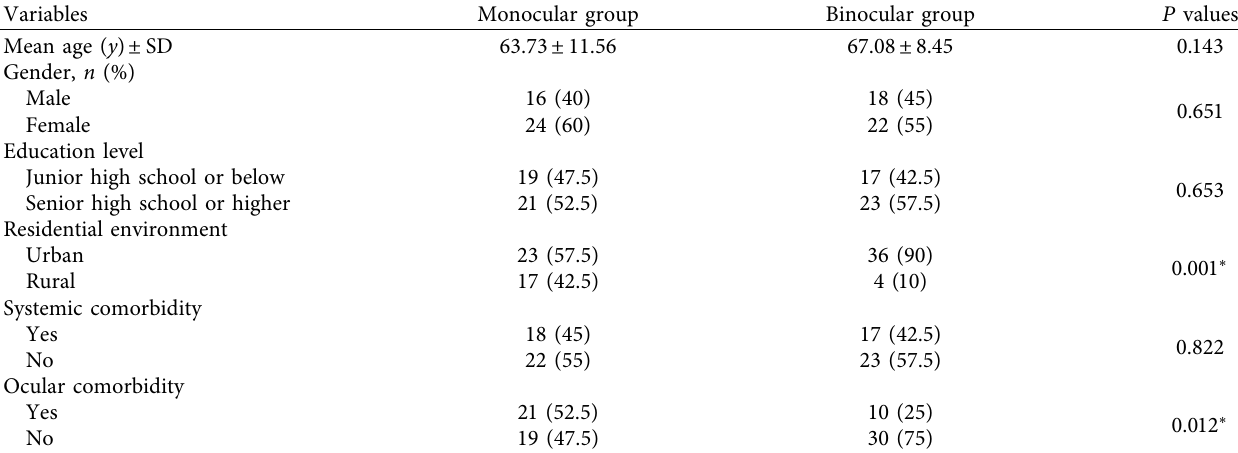
Table 1: Sociodemographic and clinical characteristics of study subjects.